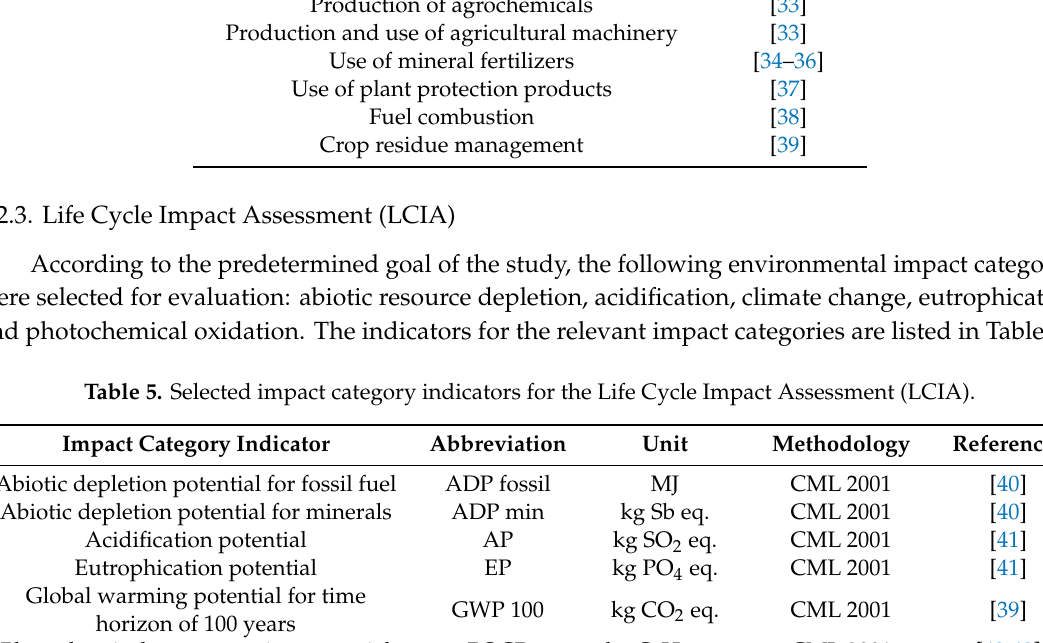
Table 5. Selected impact category indicators for the Life Cycle Impact Assessment (LCIA).